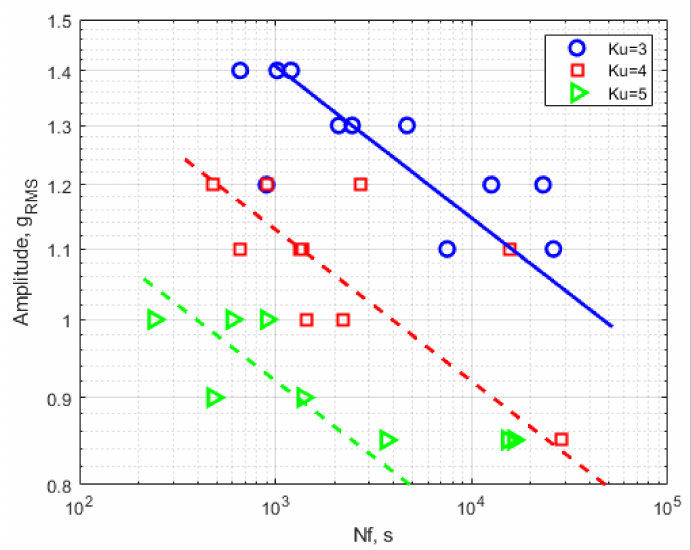
Figure 5. S–N curves for the three kurtosis